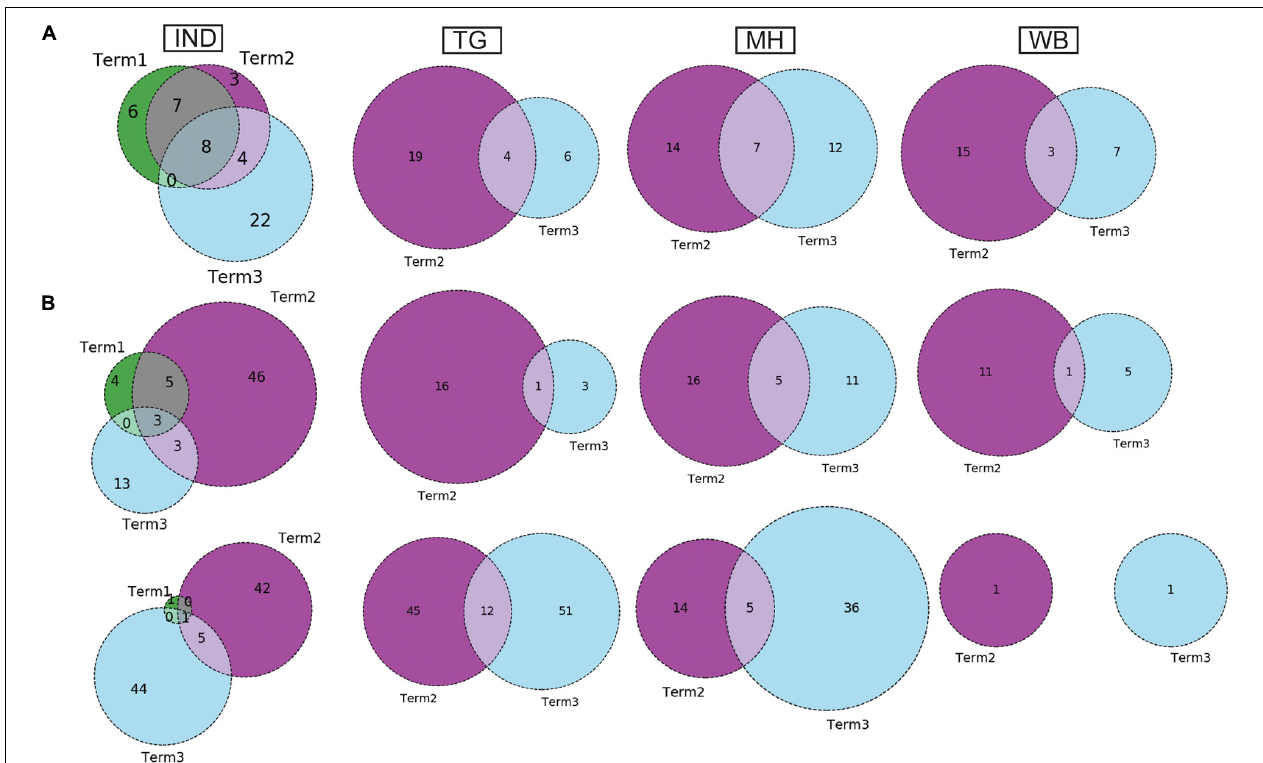
FIGURE 5 | Dynamics of mutation and co-mutation pattern in Indian states across time spans. (A) The overlap of frequent mutations observed in overall Indian samples (IND), Telangana (TG), Maharashtra (MH), and West Bengal (WB), respectively, collected across Term1 (green), Term2 (purple), and Term3 (cyan). (B) The overlap of co-mutation patterns in three “Terms” where the upper panel represents an overlap of co-mutations having mutations between ≥ 3 and ≤ 5 sequences. The lower panel represents an overlap for > 5 co-mutations per sequence.